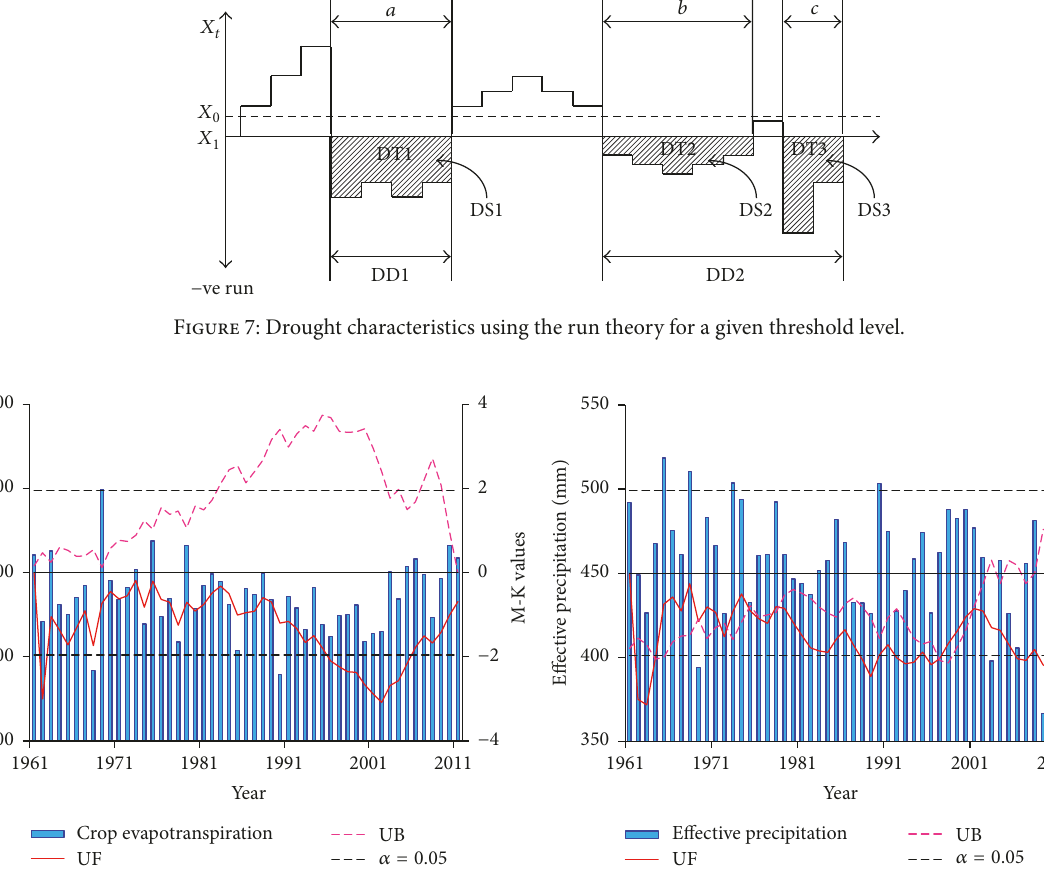
Crop evapotranspiration